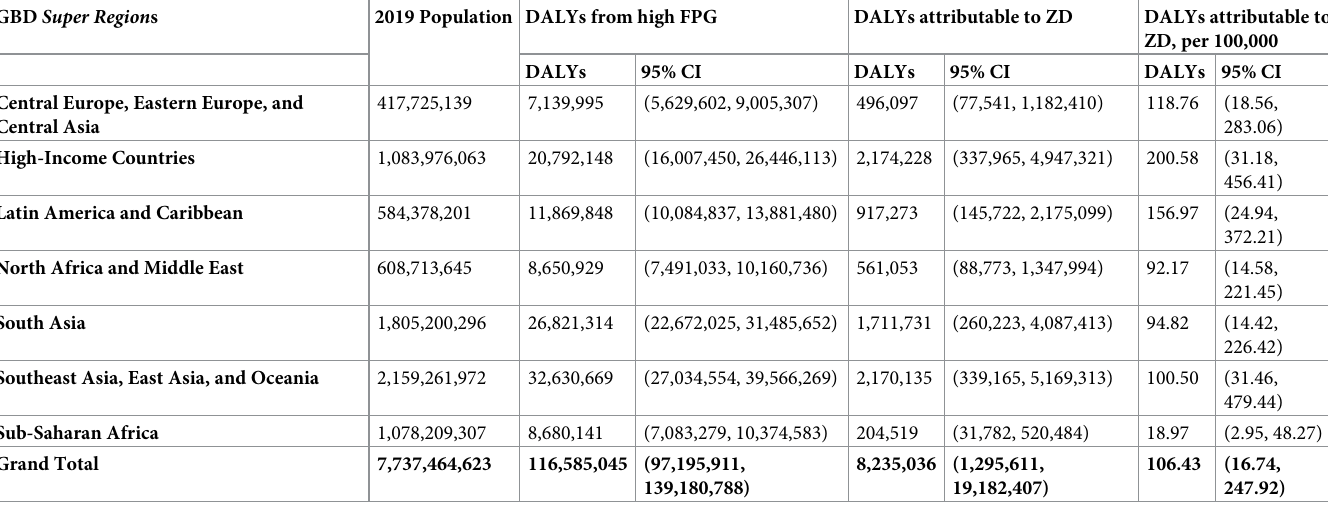
Table 4. Total DALYs � , DALYs (total and standardized) attributable to ZD by GBD Super Region s, 2019. GBD Super Region